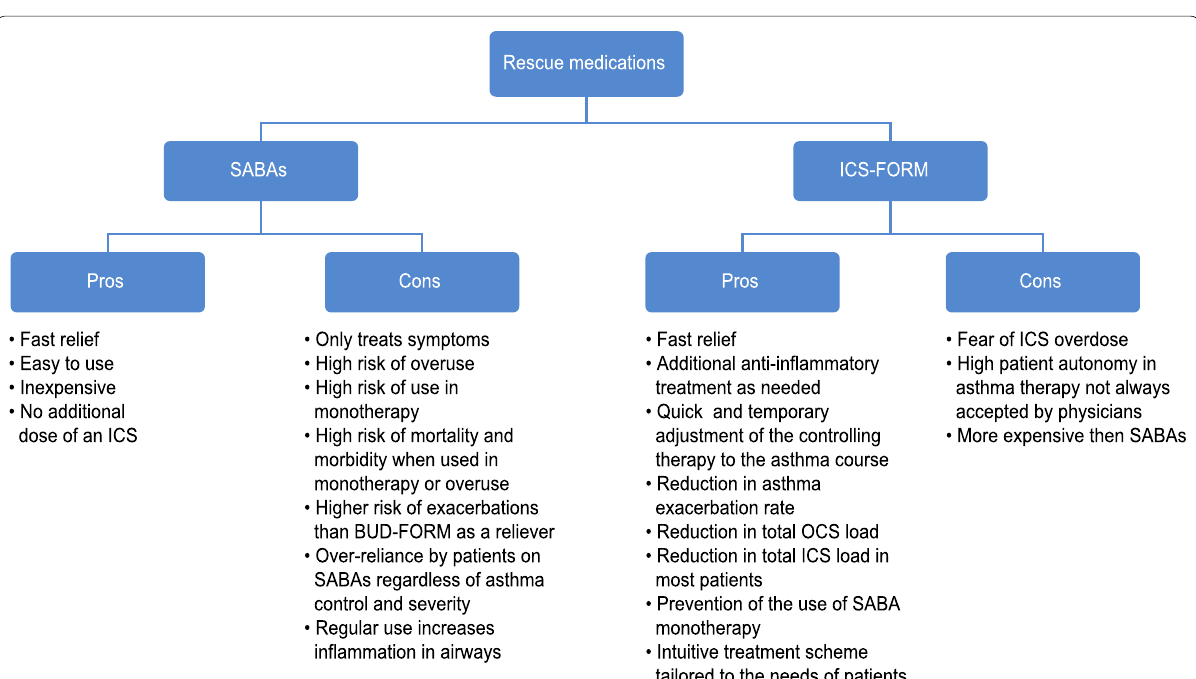
Fig. 5 Pro and con for using SABA and ICS‑FORM as relivers. SABA short acting beta2 agonist, ICS inhaled corticosteroids, FORM